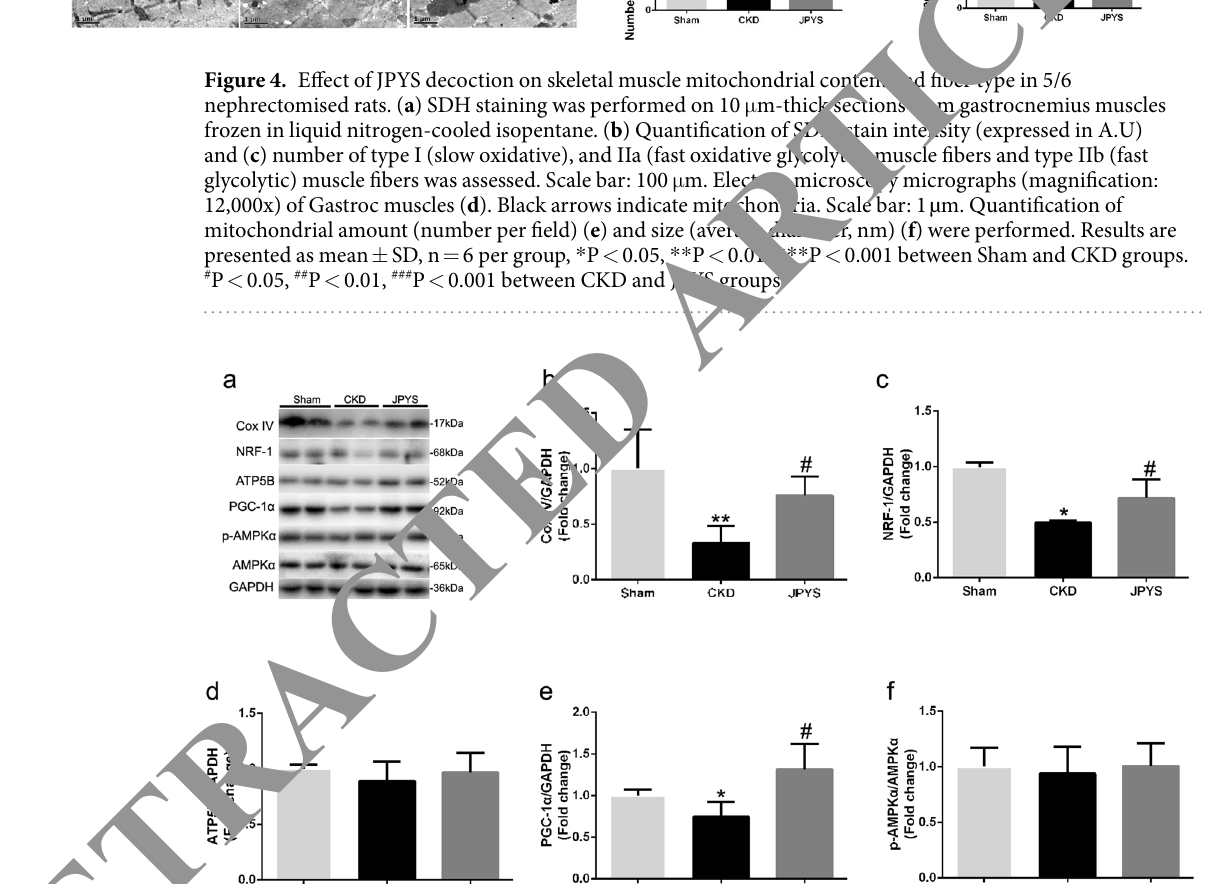
Figure 5. Effect of JPYS decoction on skeletal muscle mitochondrial biogenesis proteins in 5/6 nephrectomised rats. ( a ) Representative Western blot images of Cox IV, NRF-1, ATP5B, PGC-1 α , phosphorylated (p) form of AMPK α and AMPK α protein expression. ( b ) Quantification of Cox IV, ( c ) NRF-1, ( d ) ATP5B, ( e ) PGC-1 α protein levels and ( f ) p-AMPK α and AMPK α ratio. GAPDH was used as loading control. Data are expressed as Fold change vs. Sham and reported as means ± SD, n = 6 per group, * P < 0.05, ** P < 0.05 between Sham and CKD groups. # P < 0.05 between CKD and JPYS